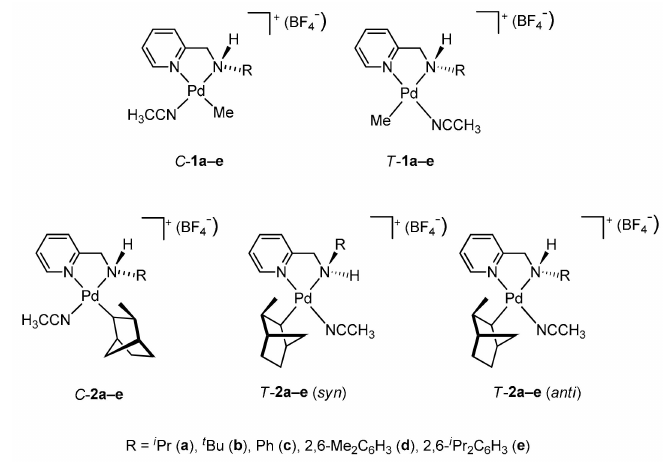
Figure 1. Isomers of complexes 1a – e and 2a – e . Table 1. Relative abundance for the isomers of 1 and 2